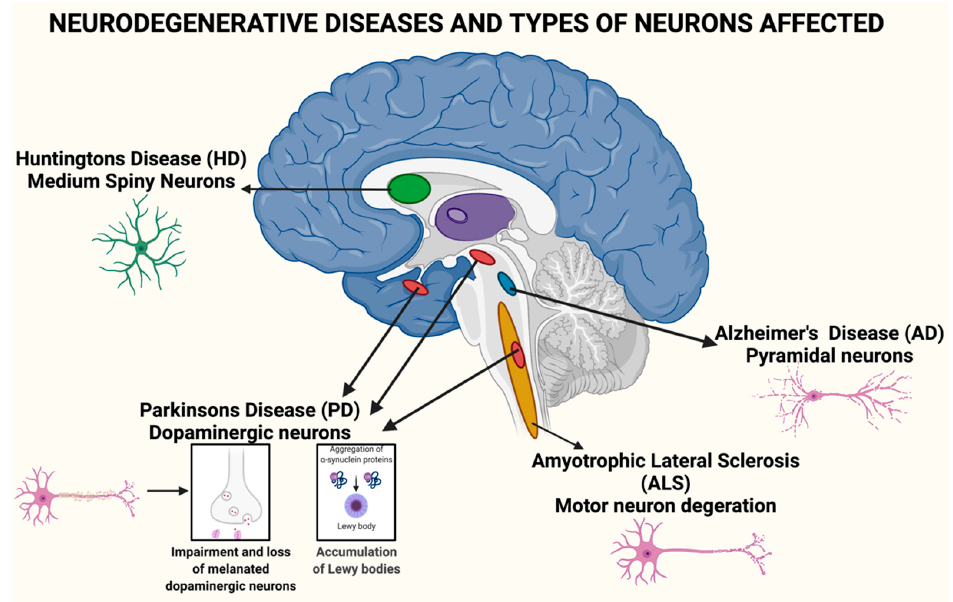
Figure 1. Neurodegenerative diseases and the types of neurons affected.